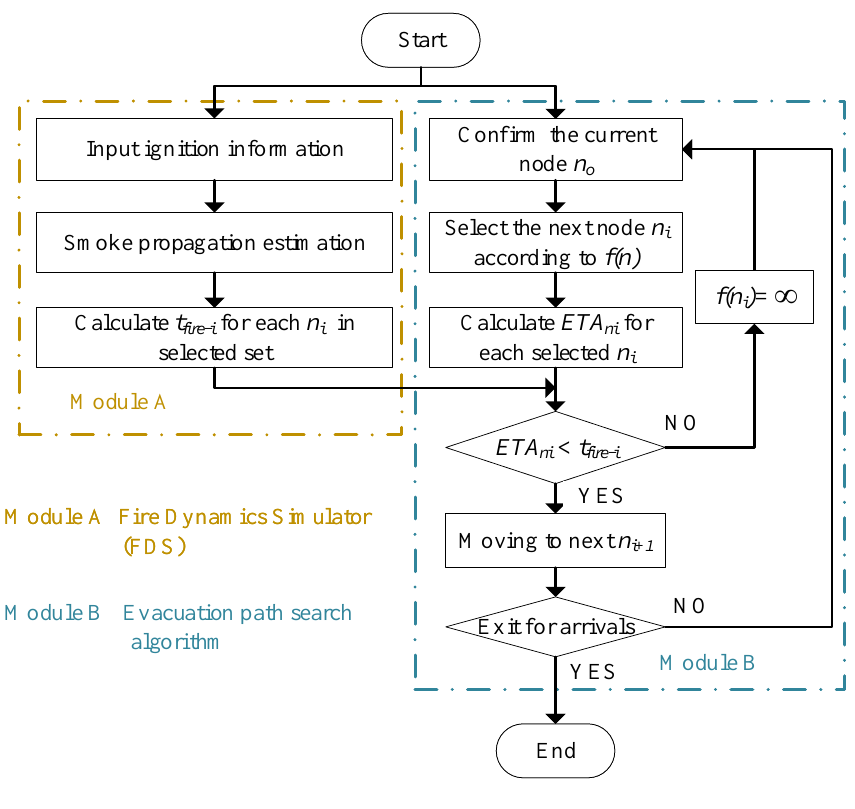
Figure 1. Framework of the improved